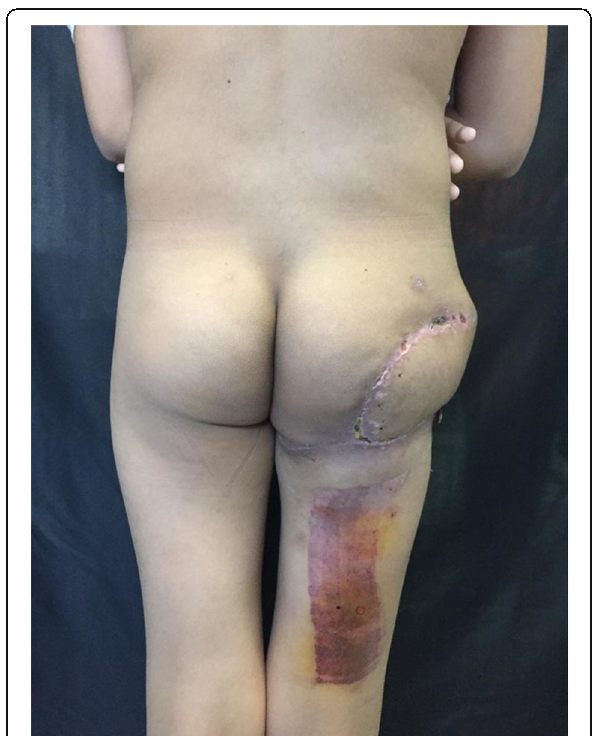
Fig. 8 Y-graft, closure of the donor area with adjacent skin tissue